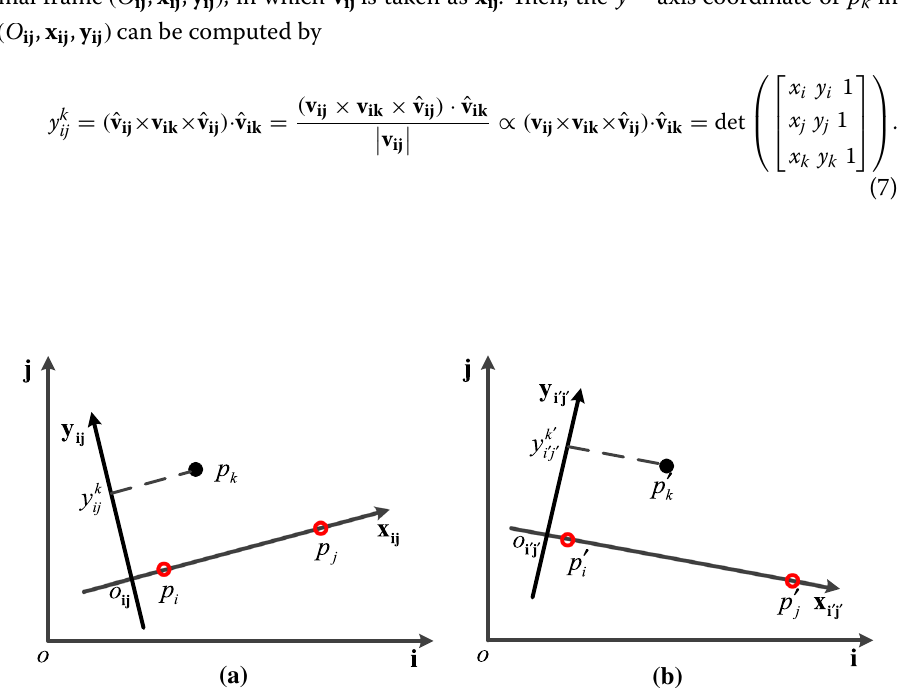
Fig. 8 The illustration of the relative position. a The relative position of p k with respect to the vector from p i to p j and b The relative position of p ′ k with respect to the vector from p ′ i to p ′